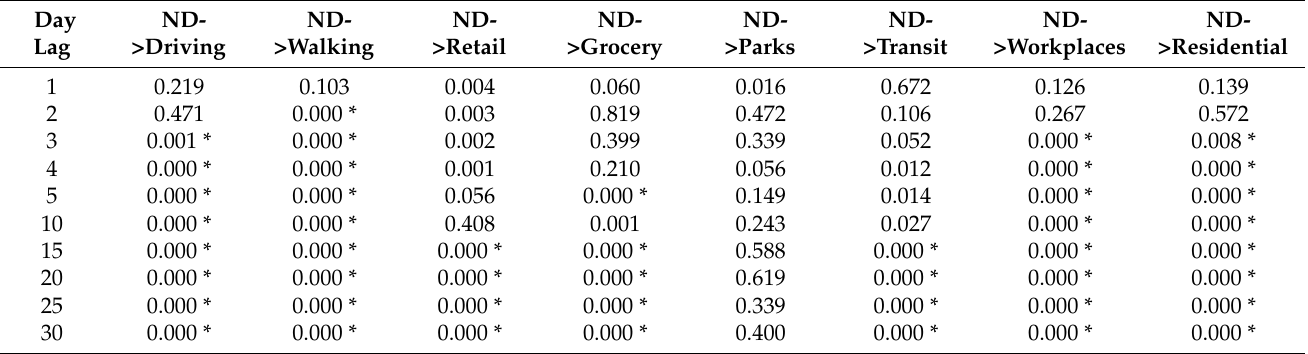
Table A14. New_deaths (ND), Granger-cause mobility variables, and p -values in day lags in Poland.